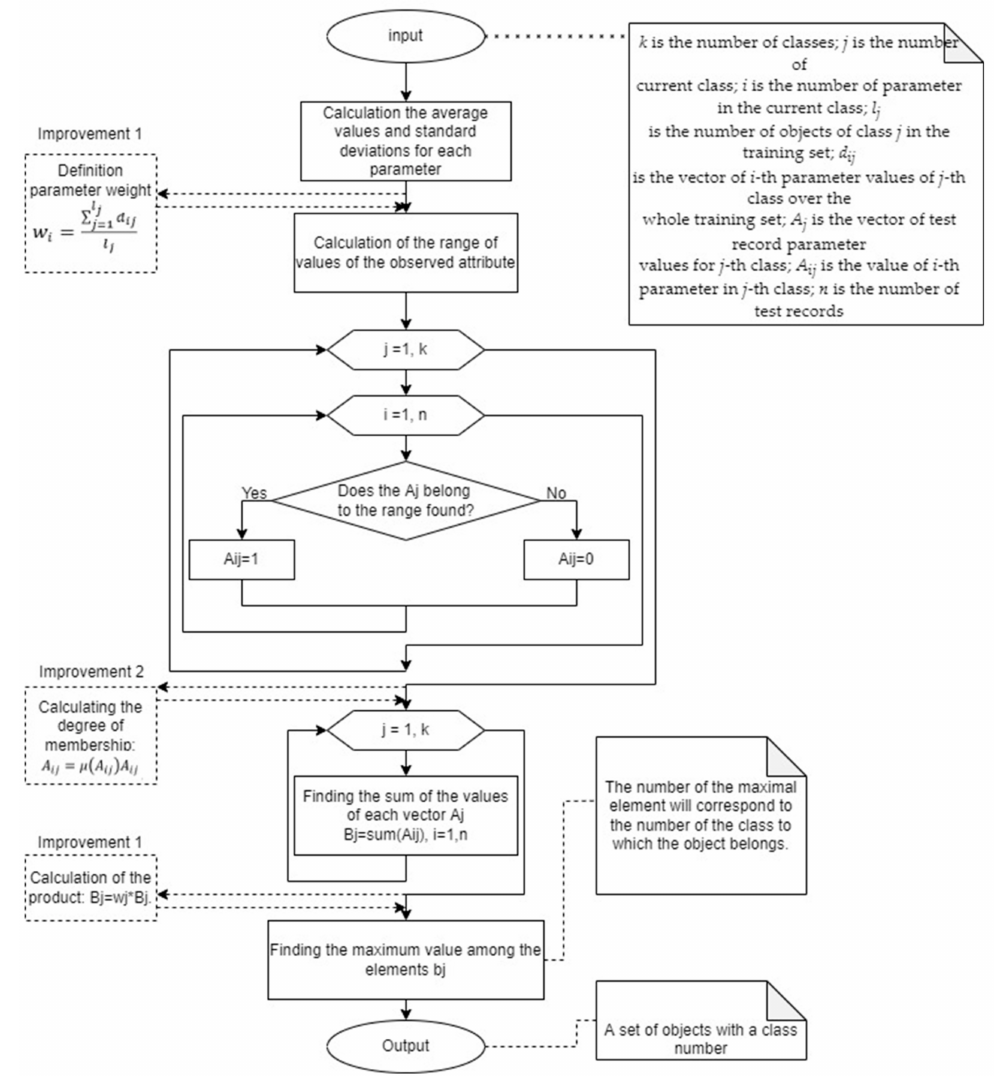
Figure 1. Flowchart of the method of classification by means of mathematical statistics (with